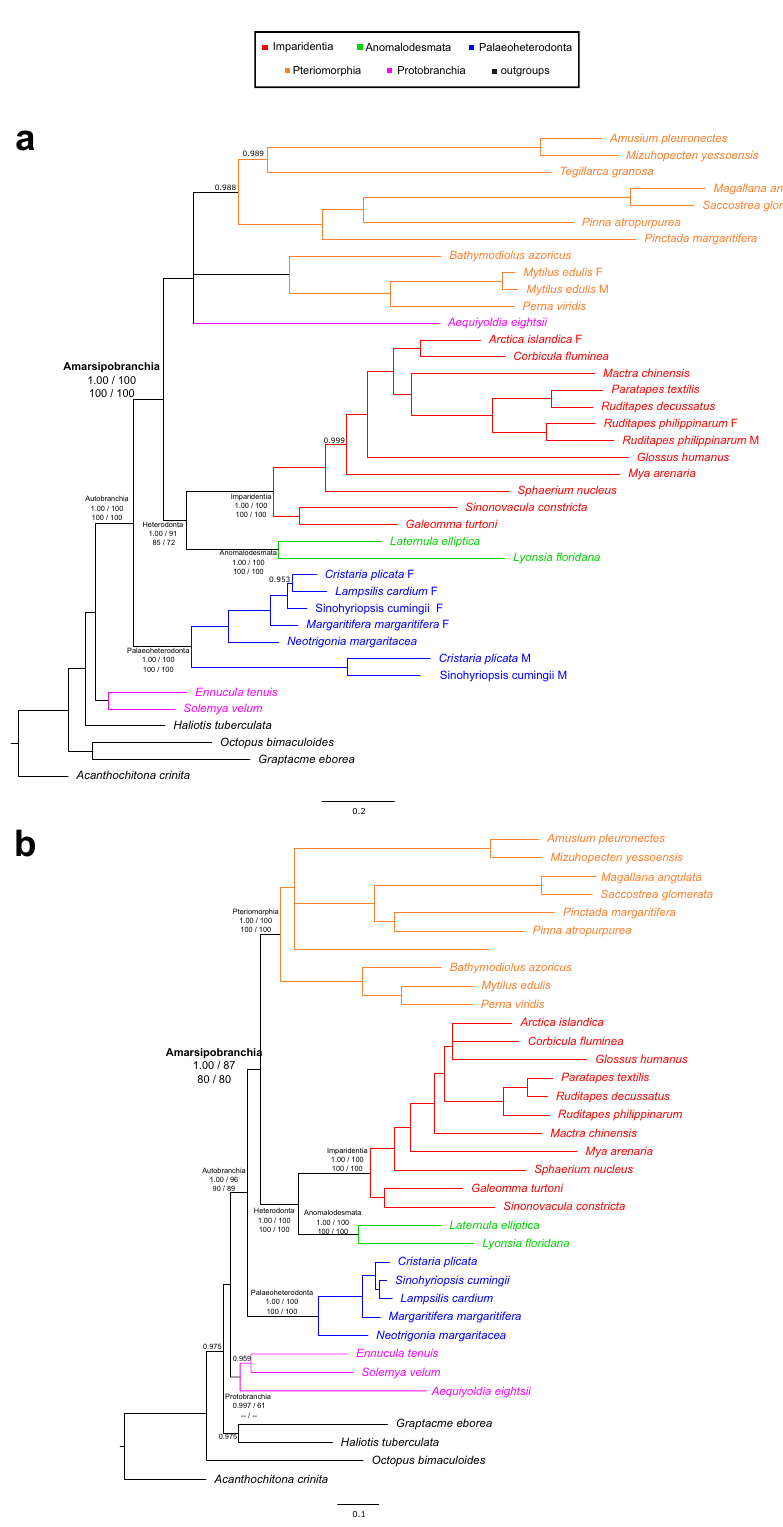
Figure 2. Bayesian trees inferred from the two OXPHOS datasets. ( a ) The mt-OXPHOS tree inferred through MrBayes. ( b ) The nu-OXPHOS tree inferred through MrBayes. Notably, both trees support the Amarsipobranchia hypothesis.The posterior proability on each node is reported when lower than 1.00; nodes with posterior probability lower than 0.95 were collapsed. Major nodes are annotated and support values of each of the four trees inferred for the present work are shown, as follows: MrBayes poterior probability, partitioned and mixture-model IQ-TREE UFBoot values, and RAxML bootstrap value. A double dash instead of the support means that the clade is not monophyletic in that tree. Red, Imparidentia; green, Anomalodesmata; blue, Palaeoheterodonta; orange, Pteriomorphia, purple, Protobranchia; outgroups are shown in